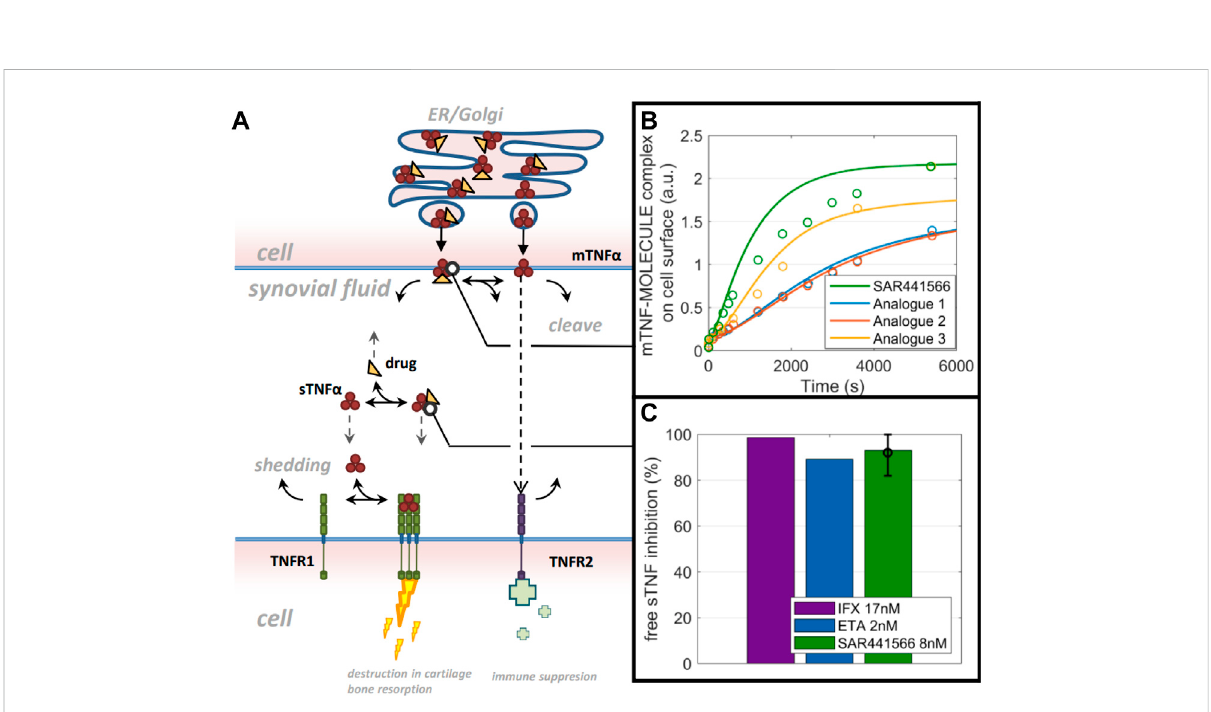
FIGURE 5 QSP model predictions: A computer model and simulations for synovial TNF biology. (A) Reduced model scheme of TNF life cycle and drug binding. (B) data on mTNF-SAR441566 complex appearance in comparison to 3 analogues from the same chemical family on cell surface (circles) andmodelprediction(lines)usingmoleculespeci fi cbindingkineticsandintracellularaccumulationfactors. (C) ModelpredictiononfreesolubleTNF inhibition in synovial fl uid for In fl iximab (IFX), Etanercept (ETA) and